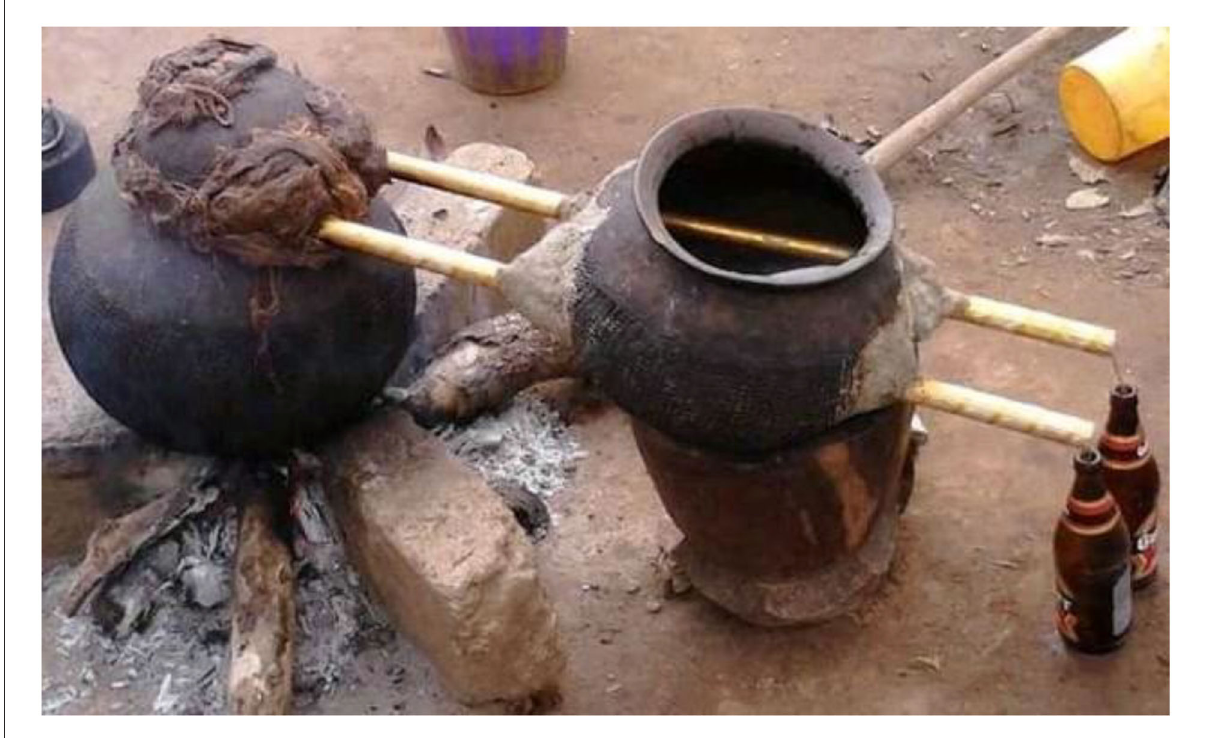
FIGURE1 The local way of ethanol